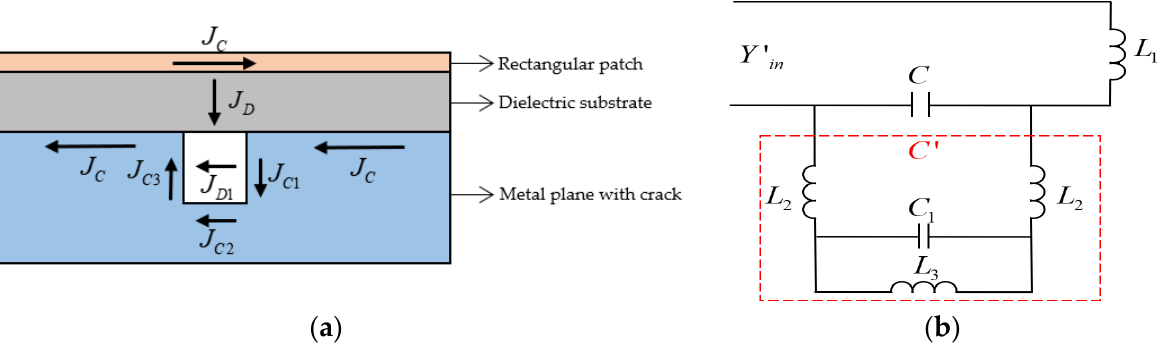
Figure 3. Equivalent model of the sensor with crack on the ground plane. ( a ) Physical model. ( b )Equivalent Circuit.